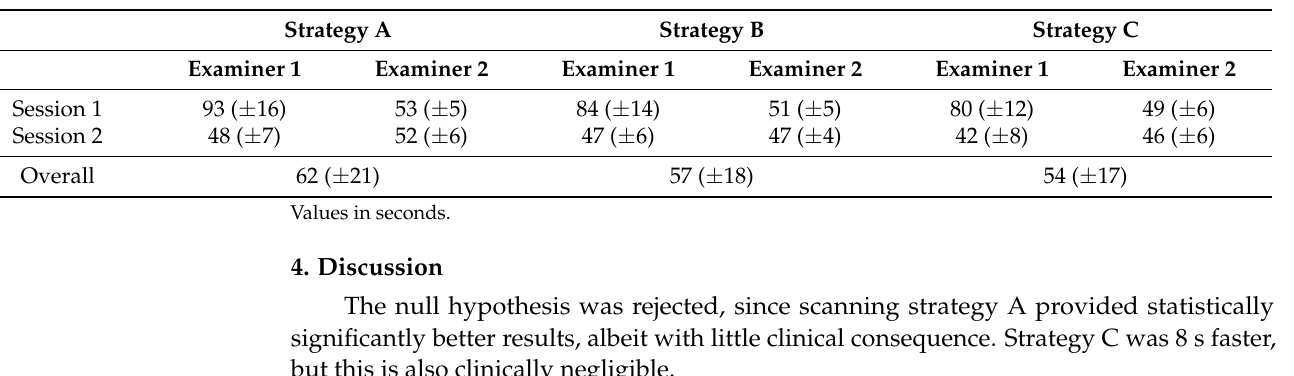
Table 6. Average scanning time ( ± standard deviation) for each scanning